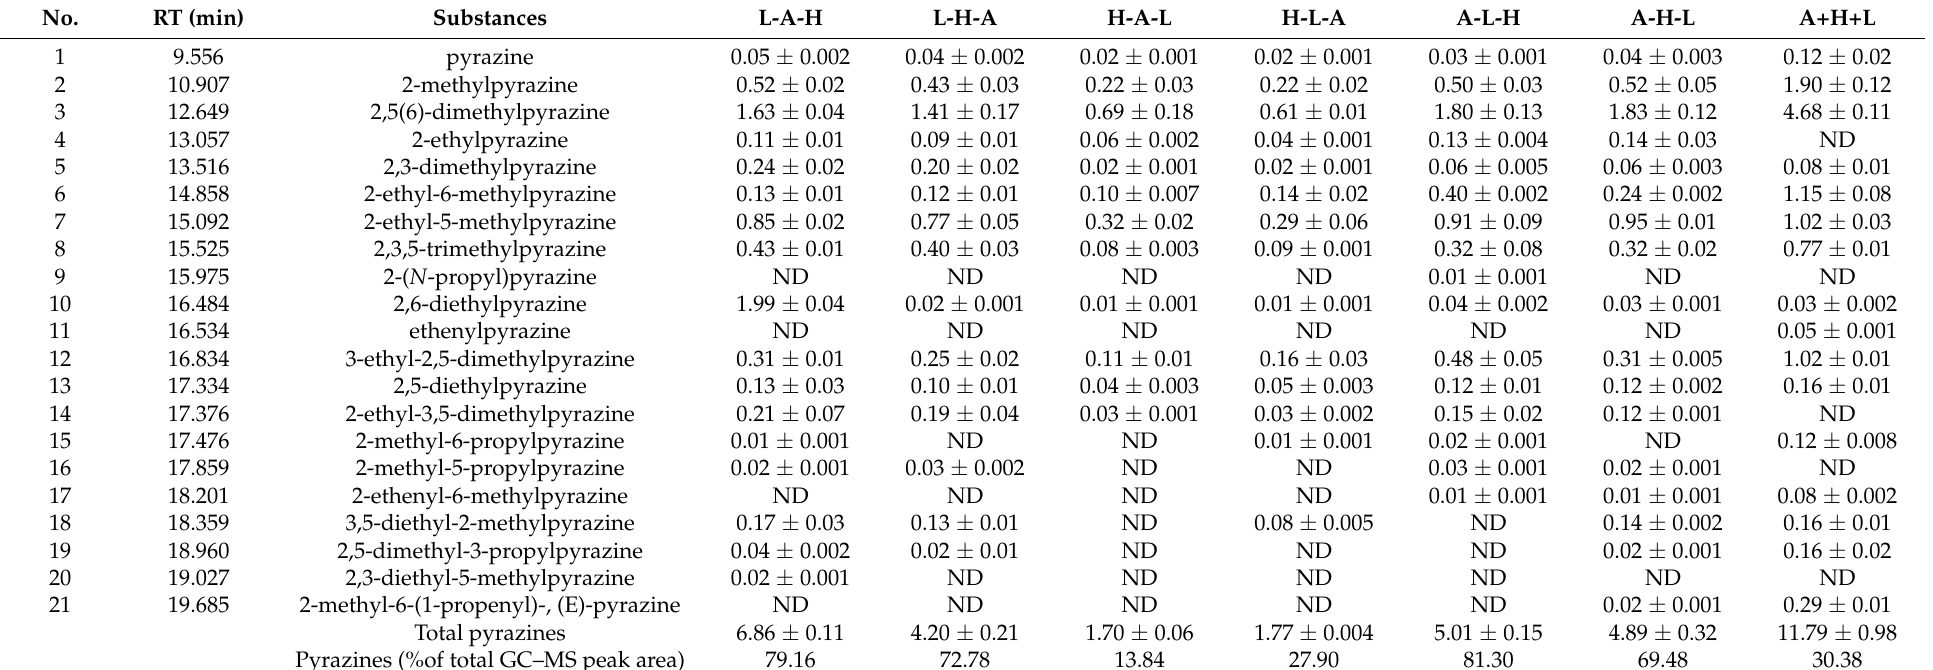
Table 3. Pyrazines contents ( µ g/g) in the model system (glucose with lysine-containing tripeptides) and in the Control (Arg + Lys+ Lys) ( p < 0.05). L-A-H: Lys-Arg-His; L-H-A: Lys-His-Arg; H-A-L: His-Arg-Lys; H-L-A: His-Lys-Arg; A-L-H: Arg-Lys-His; A-H-L: